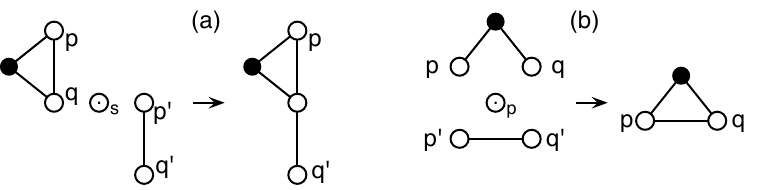
Fig. 1: Operations on series-parallel